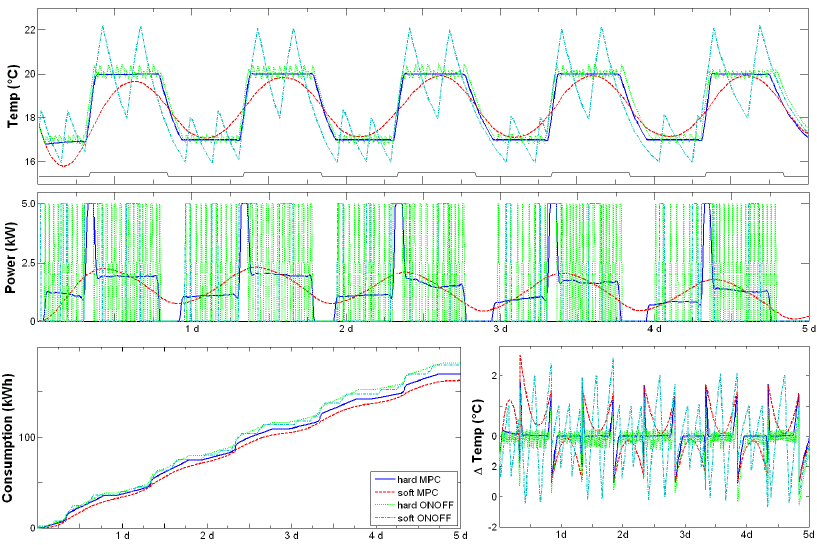
Figure 6. Comparison between Model Predictive Control (MPC) and Hysteresis control. Indoor temperature, power consumption pattern, consumed energy and deviation from the setup for a 5-day period. Black line represents the temperature reference evolution. Table 1. Hysteresis band definition for the ON-OFF controls.